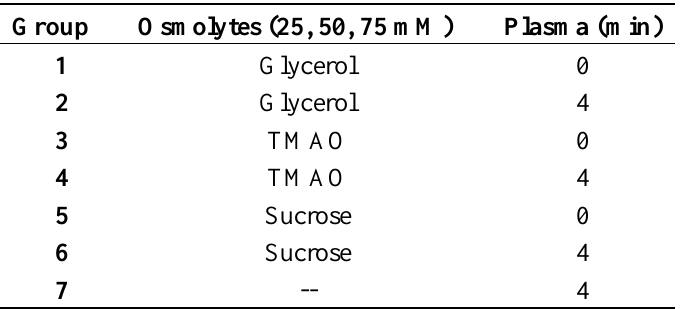
Table 1. Group description for treatment of human